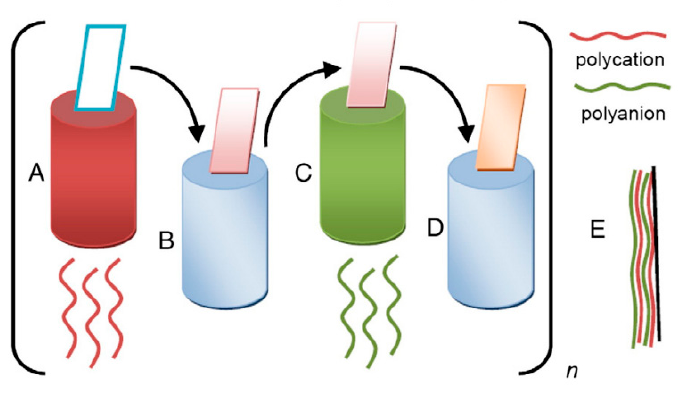
Figure 1. Layer-by-Layer schematic process [36].